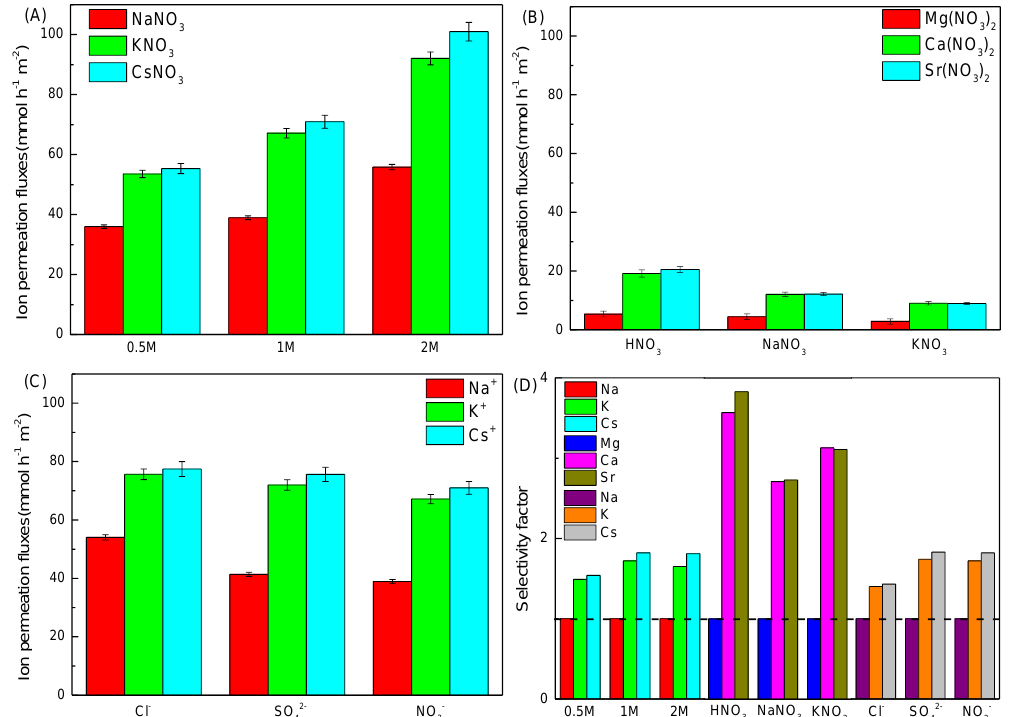
Figure 5. E ff ect of nitric acid concentration ( A ) and species of the driving solution in permeate tank ( B ); E ff ect of salts species in feed tank ( C ); and separation factor of mixed ions ( D ). ( A ) NaNO 3 , KNO 3 and CsNO 3 mixed solution in feed tank, 0.5, 1.0, or 2.0 mol / L HNO 3 in permeate tank; ( B ) Mg(NO 3 ) 2 , Ca(NO 3 ) 2 and Sr(NO 3 ) 2 in feed tank, 1.0 mol / L HNO 3 , NaNO 3 or KNO 3 in permeate tank ( C ) chloride, sulfate and nitrate salt of Na, K, Cs in feed tank, 1.0 mol / L HNO 3 in permeate tank; [M] = 0.02 mol / L, t = 12h.